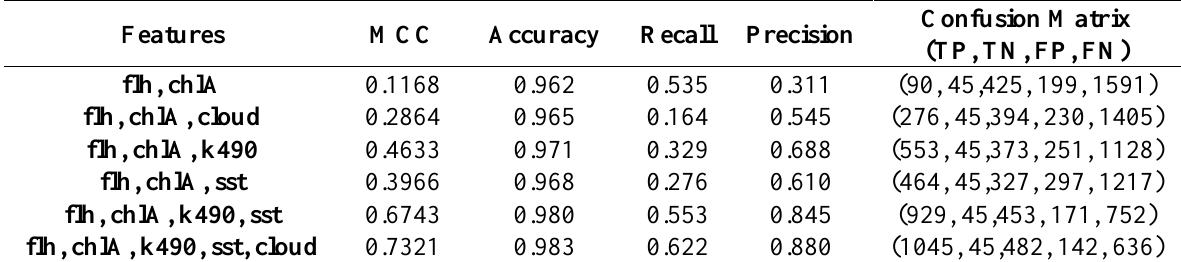
Figure 7. ROC curves based on SVM at different MCI thresholds with various combinations of features. The MCI thresholds are at the top of each subfigure ( a – d ). Table 3. Test results based on Random Forest with MCI threshold